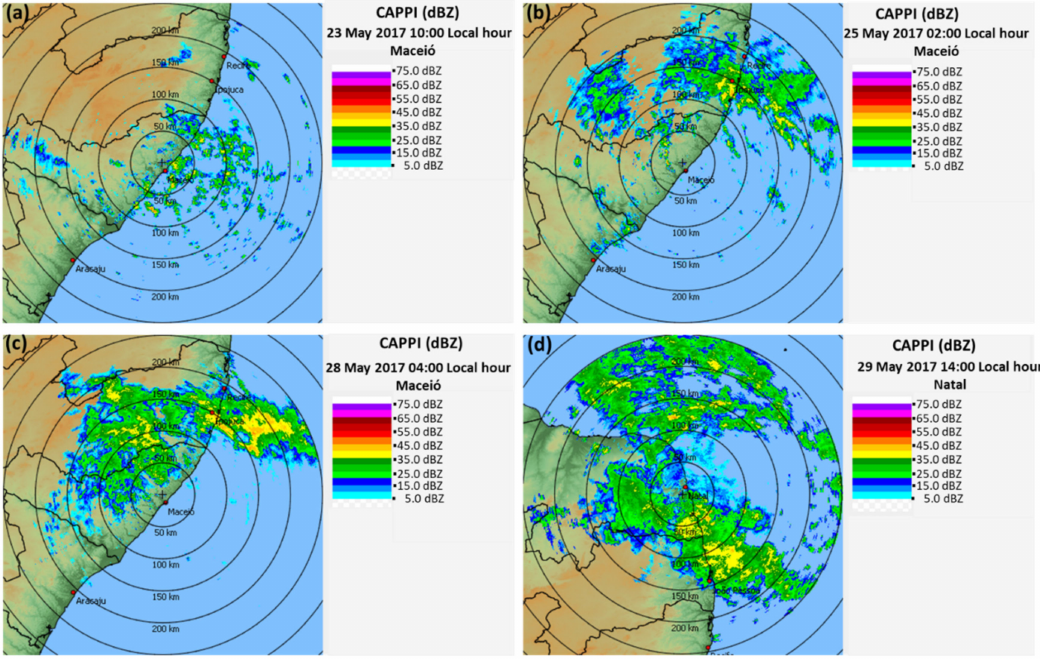
Figure 10. Reflectivity of the meteorological radars of Macei ó ( a – c ) and Natal ( d ) using the CAPPI product of 3 km for the 24 ( a ), 25 ( b ), 28 ( c ), and 29 ( d ) May